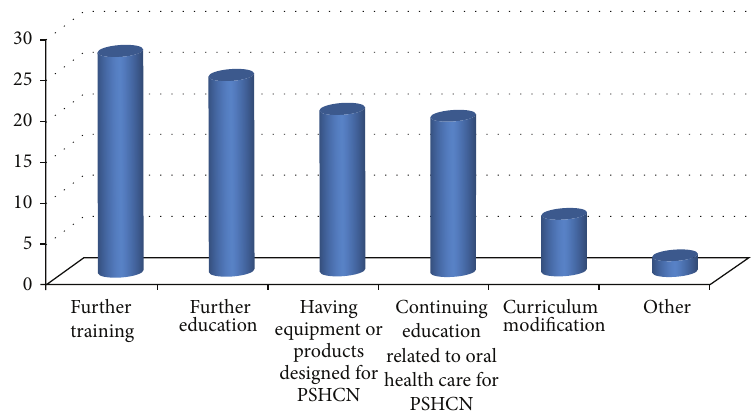
Figure 1: The answer to the question: which of the following would improve your ability to provide oral health care for persons with special needs?